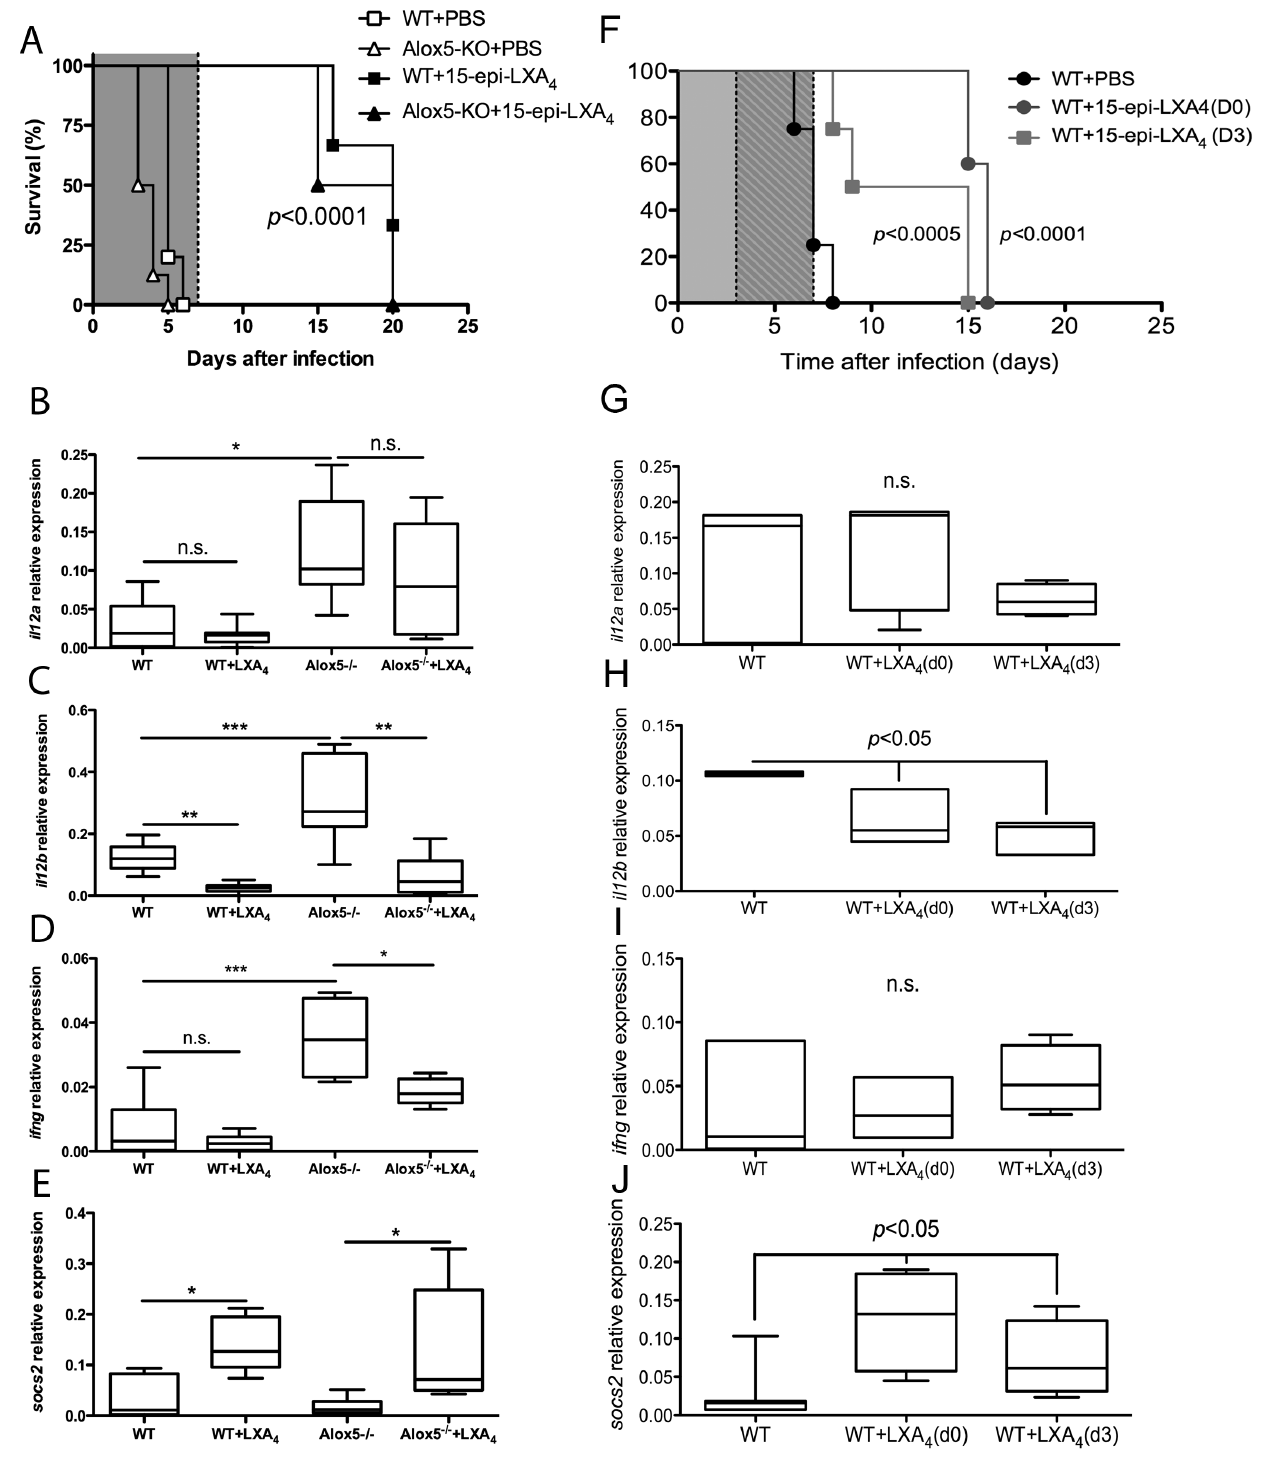
Figure 5. Exogenous delivery of 15-epi-LXA 4 prolongs survival and reduces pro-inflammatory cytokine production of both WT and 5-LO-deficient mice after P.berghei ANKA infection. C57Bl/6 WT and Alox5 2 / 2 ( n =8 mice/group) mice were infected i.p. with P. berghei ANKA strain and treated with PBS alone or with 15-epi-LXA 4 (1 m g/mouse) from day 1 to 7 after infection (shaded area in A and F) or from day 3 to 7 after infection (striped area in F). Survival was monitored (A and F) up to 20 days after inoculum. Five days after infection, mice were sacrificed and brains harvested. Tissues were homogenized, total RNA extracted and reverse transcribed for real-time RT-PCR determination of il12a (B and G), il12b (C and H), ifng (D and I) and socs2 (E and J) expression. Data shown boxes/mean bar with min-max whiskers and are representative of three independent experiments performed. (* = p , 0.05, ** = p , 0.01 and *** = p , 0.0001) as determined by One-way ANOVA with Tukey multiple comparison test.